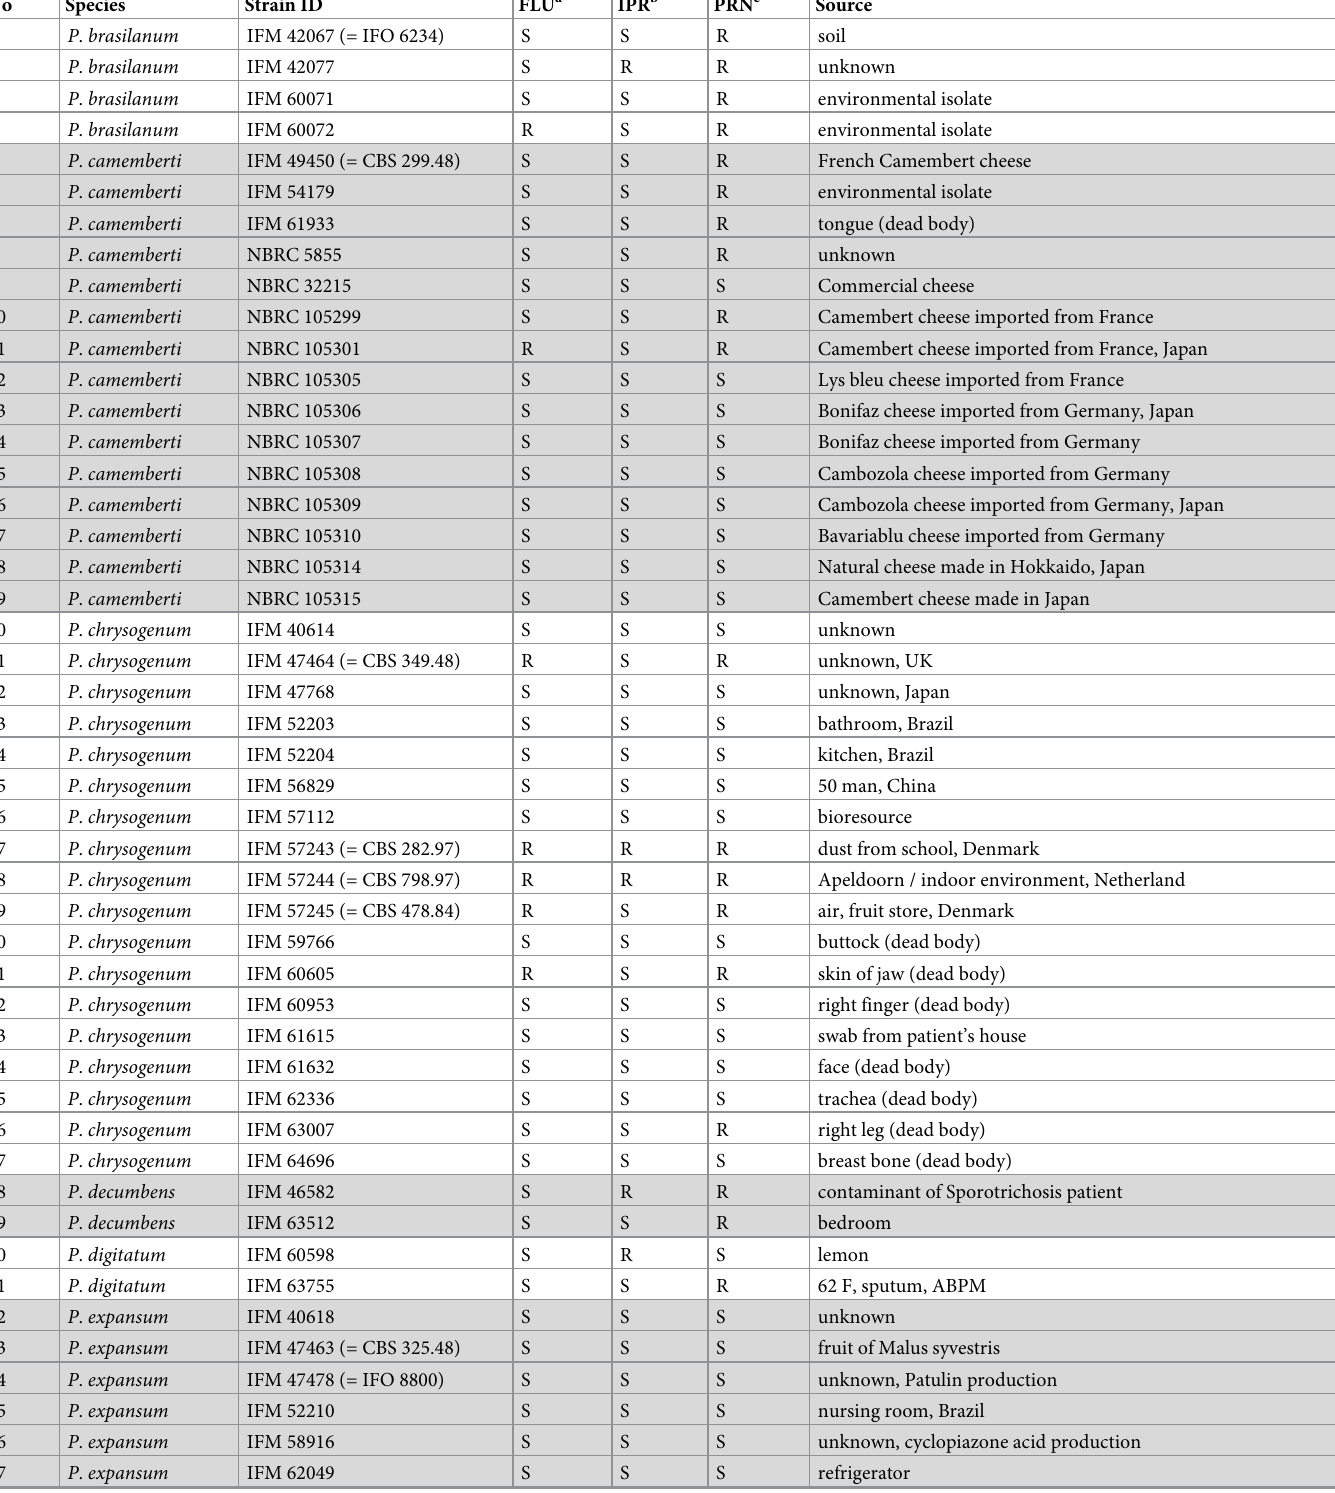
Table 1. The Penicillium strains used in this